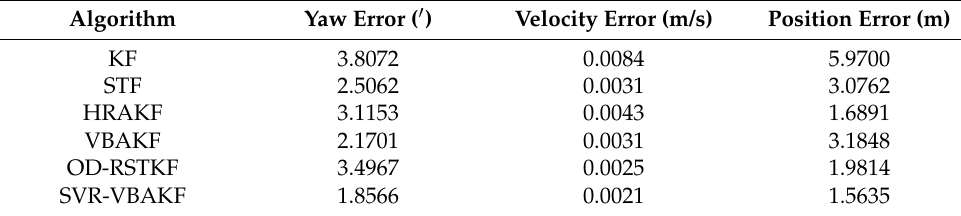
Table 2. STD for Yaw, Velocity and Position